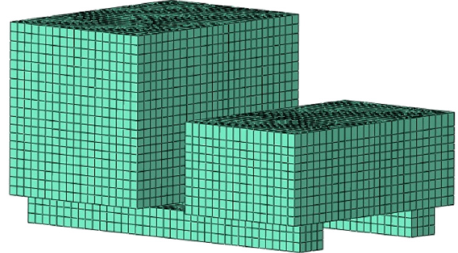
Figure 17: Floating raft system